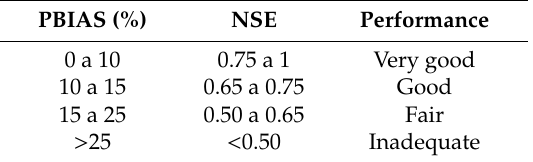
Table 5. Reference values of PBIAS and NSE and their relation with hydrologic model